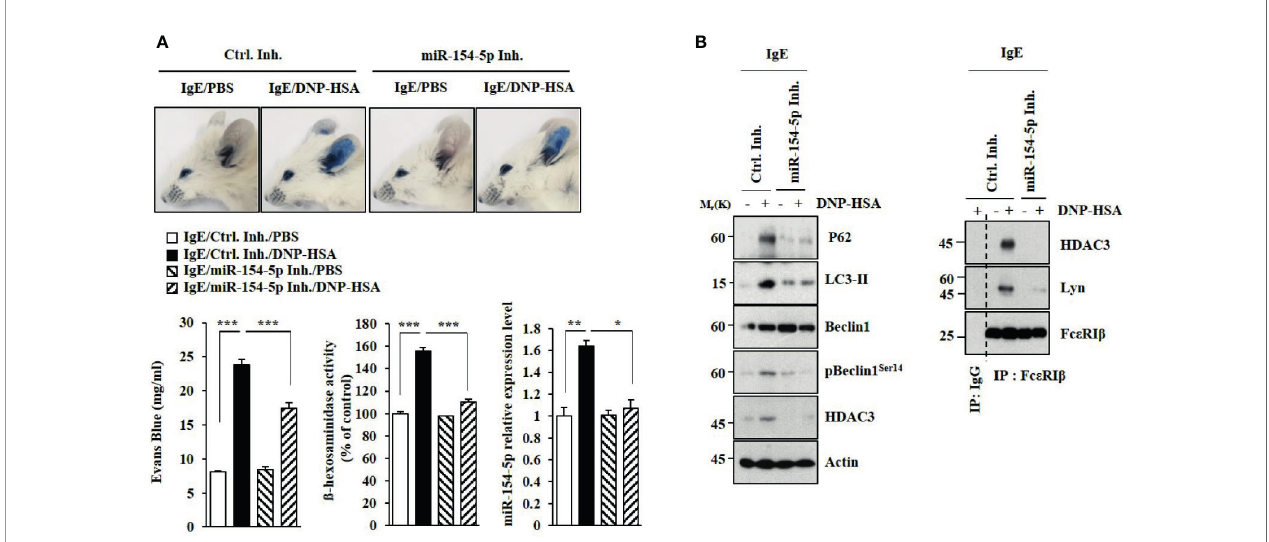
FIGURE 2 | MiR-154-5p mediates PCA. (A) BALB/C mice were intradermally injected with DNP-speci fi c IgE antibody (0.5 m g/kg) along with the indicated inhibitor (3.5 m g/kg). The next day, BALB/C mice were intravenously injected with PBS or DNP-HSA (250 m g/kg) along with 2% (v/v) Evans blue solution. The b - hexosaminidase activity assay and qRT-PCR analysis employing ear tissue lysates were performed. * p <0.05; ** p <0.01; *** p <0.001. (B) Immunoblot and immunoprecipitation employing ear tissue lysates were performed. Representative blots of three independent experiments are